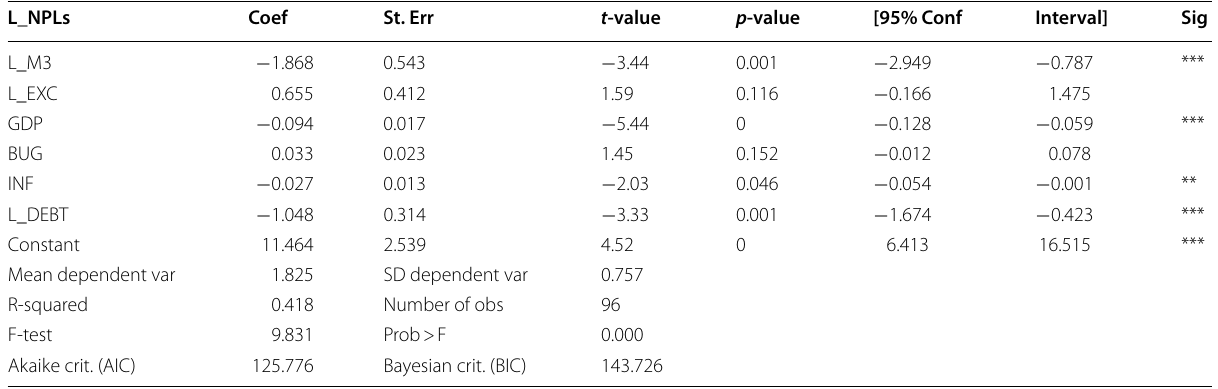
Table 8 Fixed effect